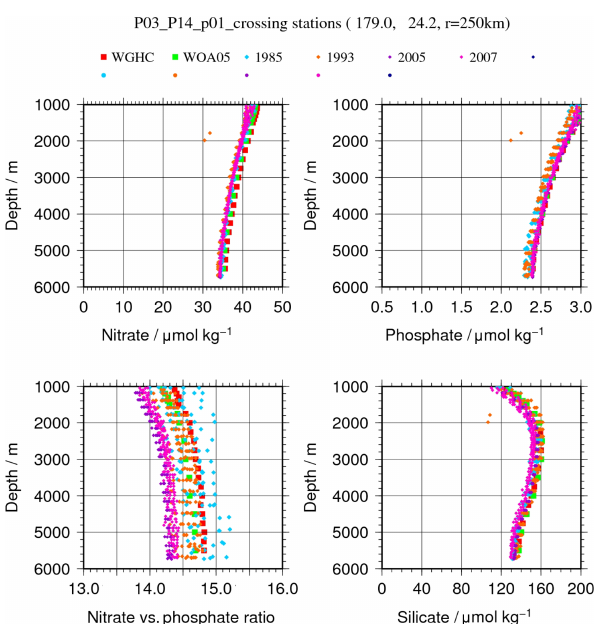
Figure 6. Example of vertical profiles of nitrate and phosphate con- centrations, the nitrate:phosphate molar ratio, and silicate concen- trations at the P03–P14 crossover (n.b., during the 2005 and 2007 cruises, the author used RMs as an in-house standard).